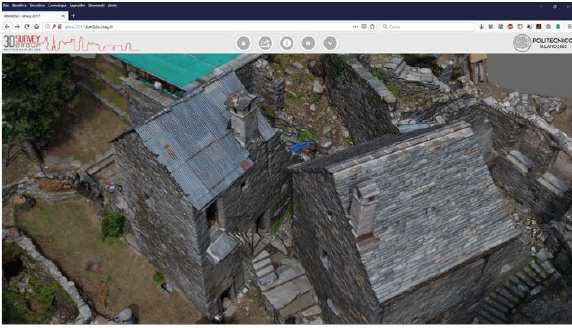
Figure 1: Textured polygonal model of the Ghesc’s site on BIM3DSG